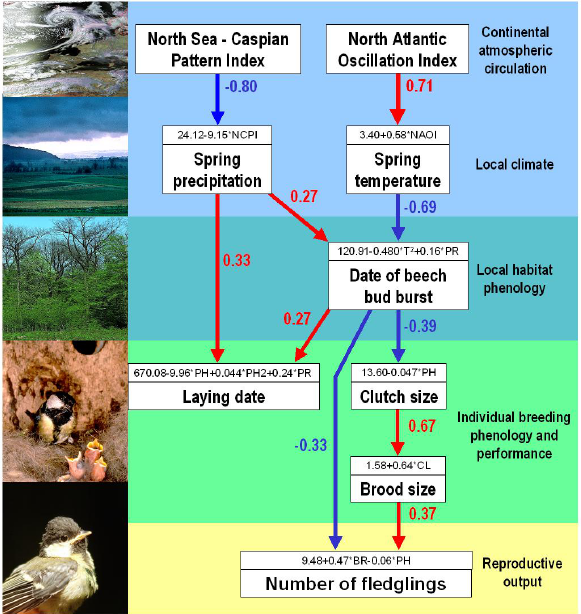
Fig. 2. Path diagram and partial equations for the chain of rela- tionships from large-scale atmospheric circulation to great tit re- productive output. For each relationship the equation (in frames) and path coefficients (bold numbers) are given. NAOI indicates Figure 2. Path diagram and partial equations for the chain of relationships from large-scale 4 North Atlantic Oscillation index; NCPI, North Sea – Caspian atmospheric circulation to great tit reproductive output. For each relationship the equation (in 5 Pattern index; T , Average annual late winter/spring temperature frames) and path coefficients (bold numbers) are given. NAOI indicates North Atlantic 6 (January–April); PR, Average annual late winter/spring precipita- tion (January–April); PH, Habitat phenology, average date of beech Oscillation index; NCPI, North Sea – Caspian Pattern index; T, Average annual late 7 bud burst; LD, Average annual laying date; CL, Average annual winter/spring temperature (Jan – Apr); PR, Average annual late winter/spring precipitation 8 clutch size; BR, Average annual brood size. Arrow colour indicates (Jan-Apr); PH, Habitat phenology, average date of beech bud burst; LD, Average annual 9 positive (red) and negative (blue) relationships. For clarity, distur- bances to the variables are not shown. Background colours indicate laying date; CL, Average annual clutch size; BR, Average annual brood size. Arrow colour 10 different stages of the cascade (see also Figs. 3–6). indicates positive (red) and negative (blue) relationships. For clarity, disturbances to the 11 variables are not shown. Background colours indicate different stages of the cascade (see also 12 figs. 3 – 6). 13